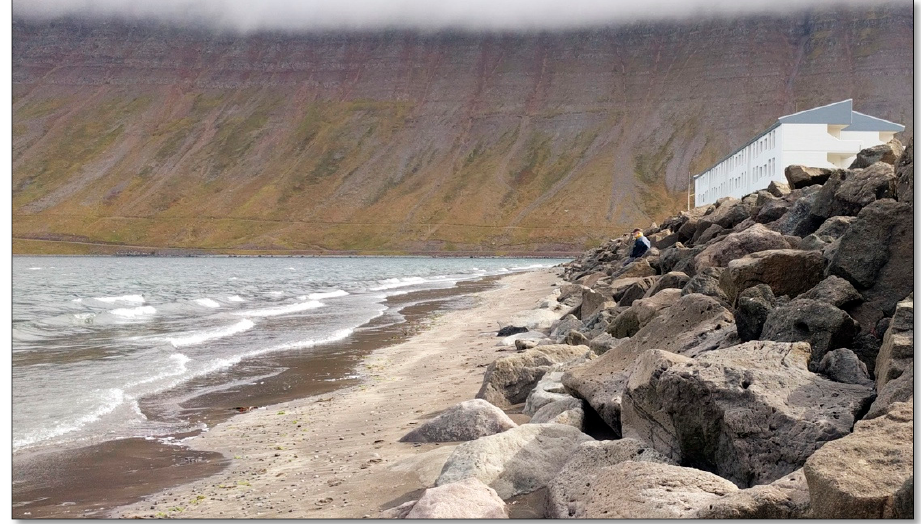
Figure 3. Fjarðarstræti Shore.